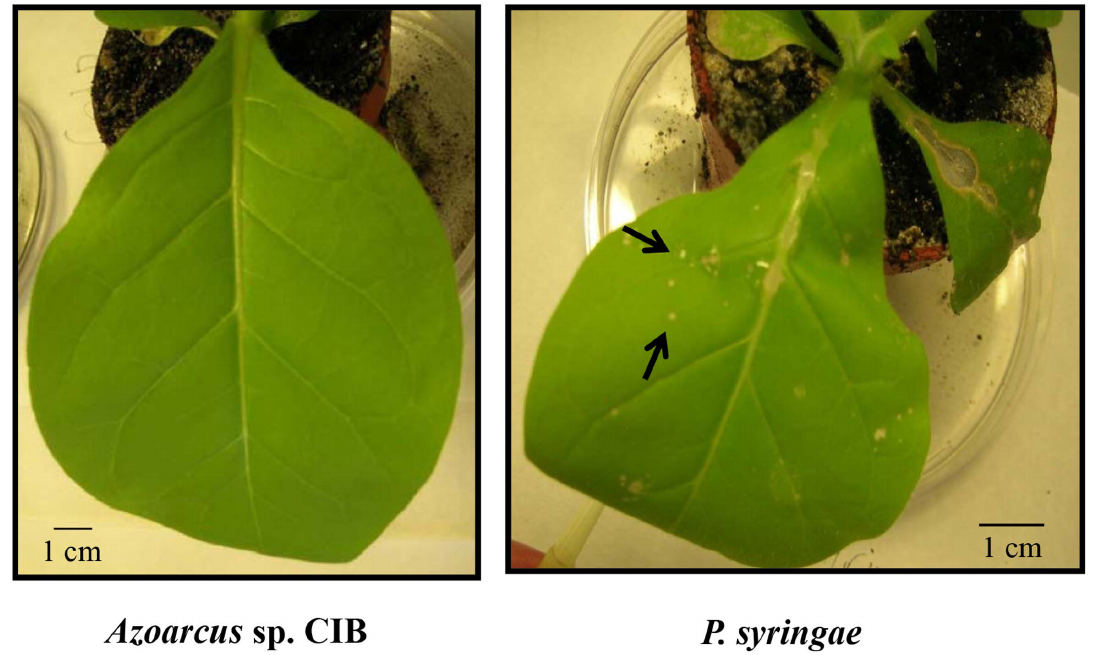
Figure 2. Azoarcus sp. CIB is a non-pathogenic bacterium. Pathogenicity test on tobacco leaves. Bacteria were infiltrated into the intercellular spaces of a tobacco leaf, which was inspected for a visible necrosis after 2 days. Necrosis is visible as light spots (arrows) on leaves infiltrated with Pseudomonas syringae pv. syringae (right) and not visible on leaves infiltrated with Azoarcus sp. CIB (left).